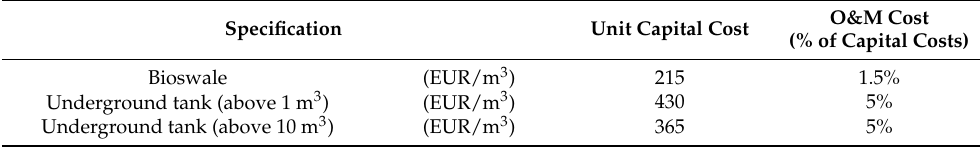
Table 7. Capital and O&M costs assumed in the analysis